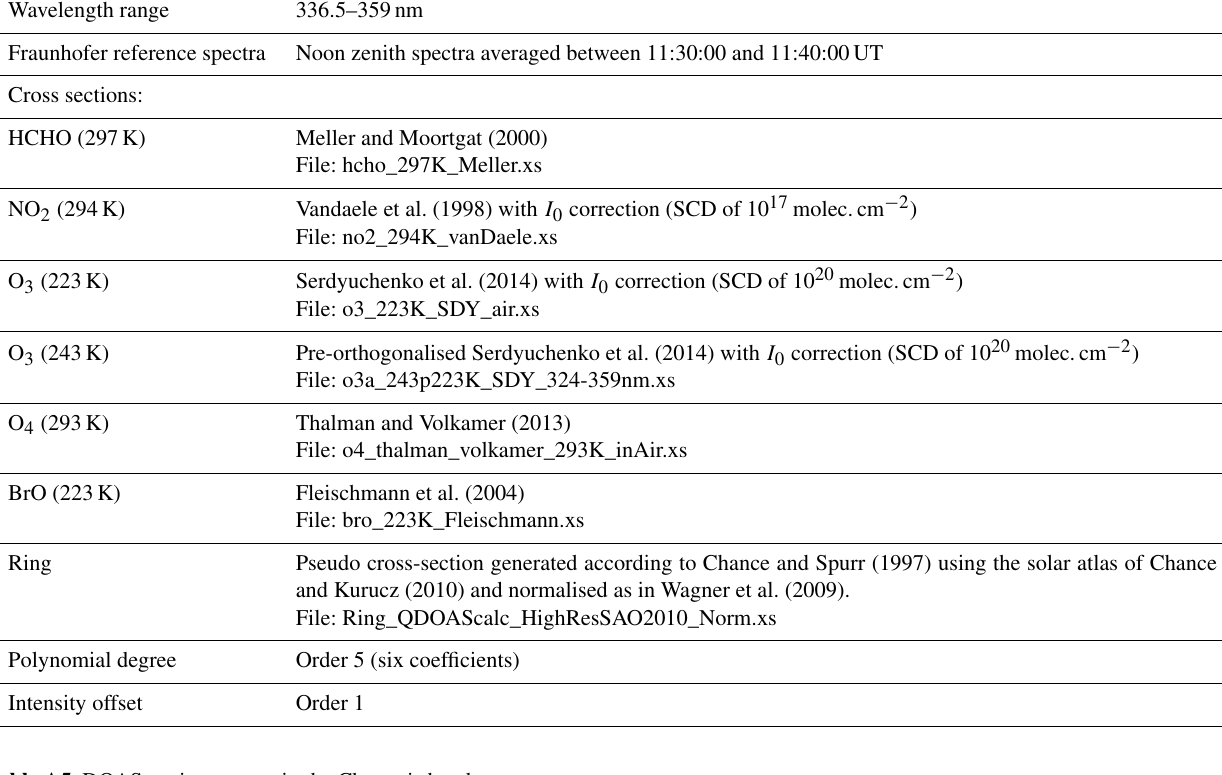
Table A5. DOAS settings ozone in the Chappuis band. Wavelength